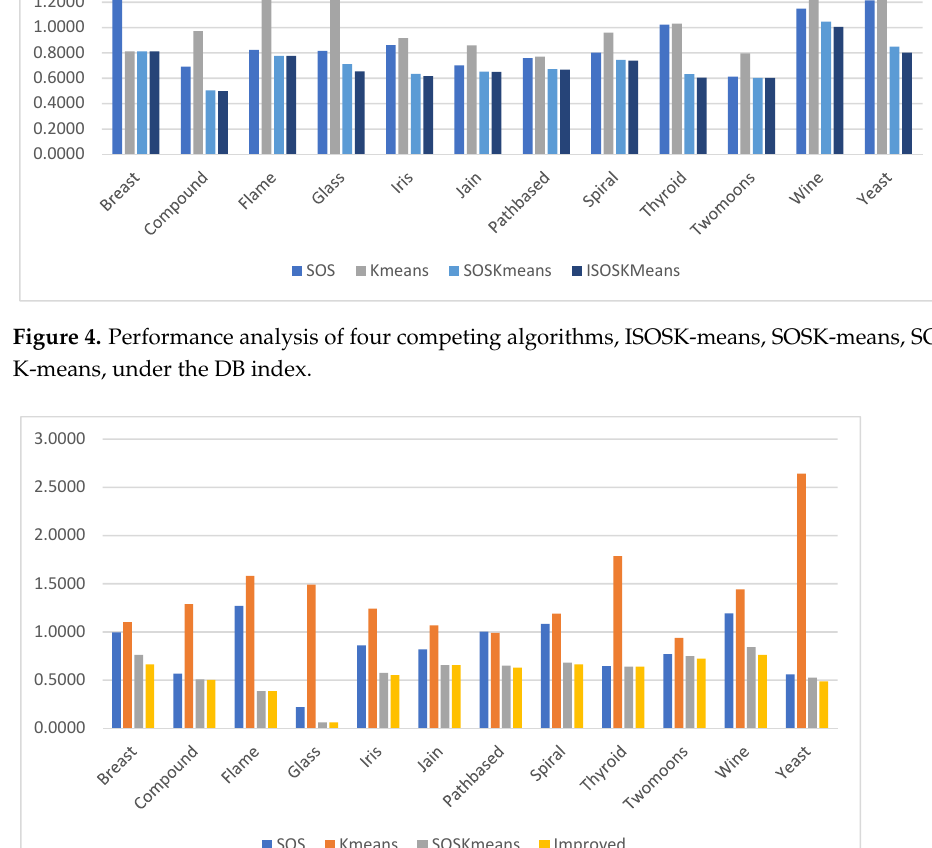
Figure 5. Performance analysis of four competing algorithms, ISOSK-means, SOSK-means, SOS and K-means, under the CS index. The average execution times of the SOS, SOSK-means and ISOSK-means algorithms for 200 generations were presented separately for each validity index, as shown in Figures 6 and 7. As expected, being a non-hybrid algorithm, the SOS recorded the lowest computational time under the two validity indices. Under the DB validity index, the ISOSK-means recorded a shorter average execution time than the SOSK-means in nine datasets. This indicated that the ISOSK-means required less execution time to achieve convergence. Under the CS validity index, the ISOSK-means recorded lower execution time in six datasets. Out of the remaining six, only three datasets showed a considerable difference in execution time for the two algorithms in favor of the SOSK-means. Since the CS index usually requires higher computational time, this result showed that the ISOSK- means substantially outperformed SOSK-means in terms of computational cost.